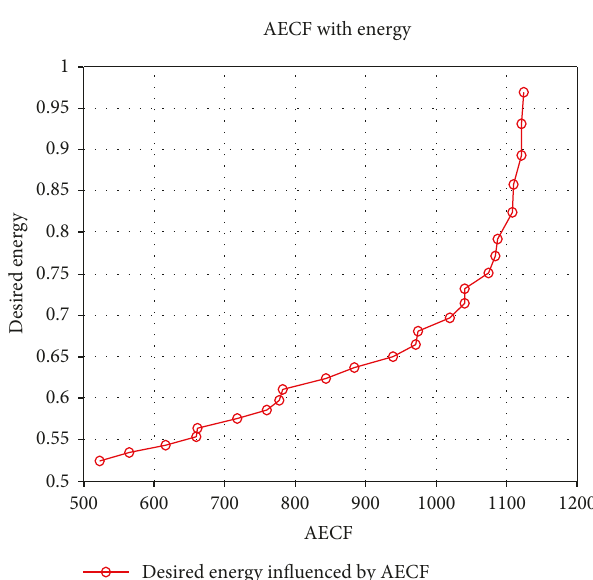
Figure 5: Relationship between the energy requirement and the AECF.